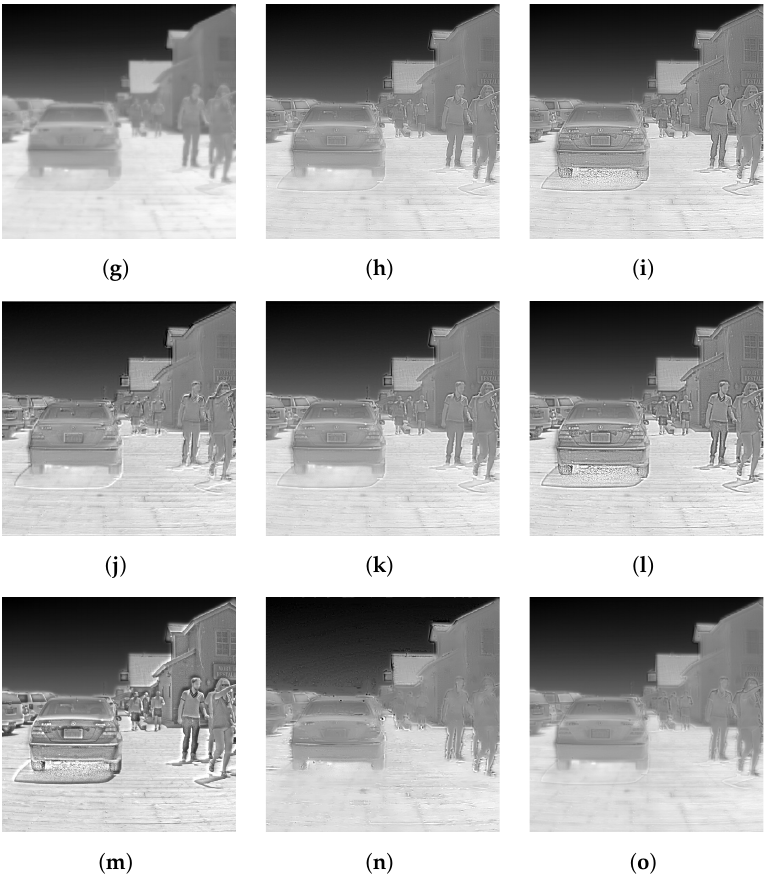
Figure A3. FLIR ADAS dataset [47] grayscale: ( a ) Reference image; ( b ) Low-resolution upsampled image; ( c ) PCA; ( d ) IHS; ( e ) BDSD; ( f ) GS; ( g ) PRACS; ( h ) HPF; ( i ) SFIM; ( j ) INDUSION; ( k ) MTF-GLP;